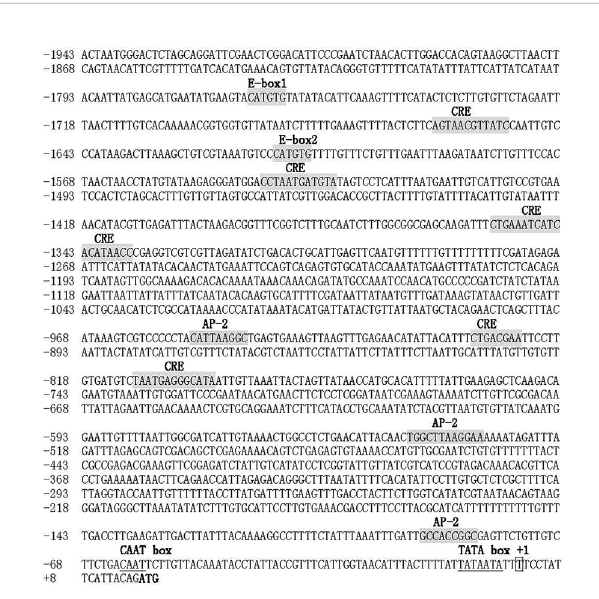
FIGURE 7 | Sequence of the Tyr promoter. The putative transcriptional start site was indicated with box, and the initiation codon was bolded. The two conserved E-box, six CRE sites, two AP-2 sites were shaded in gray. The putative CAAT box and TATA box were